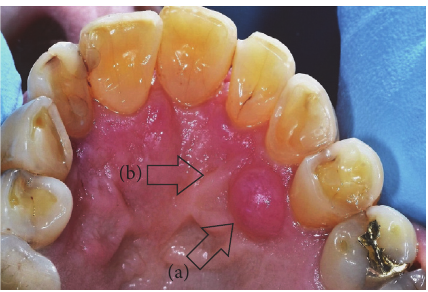
Figure 1: Clinical aspect of the PA. (a) The main lesion. (b) The smaller lesion.